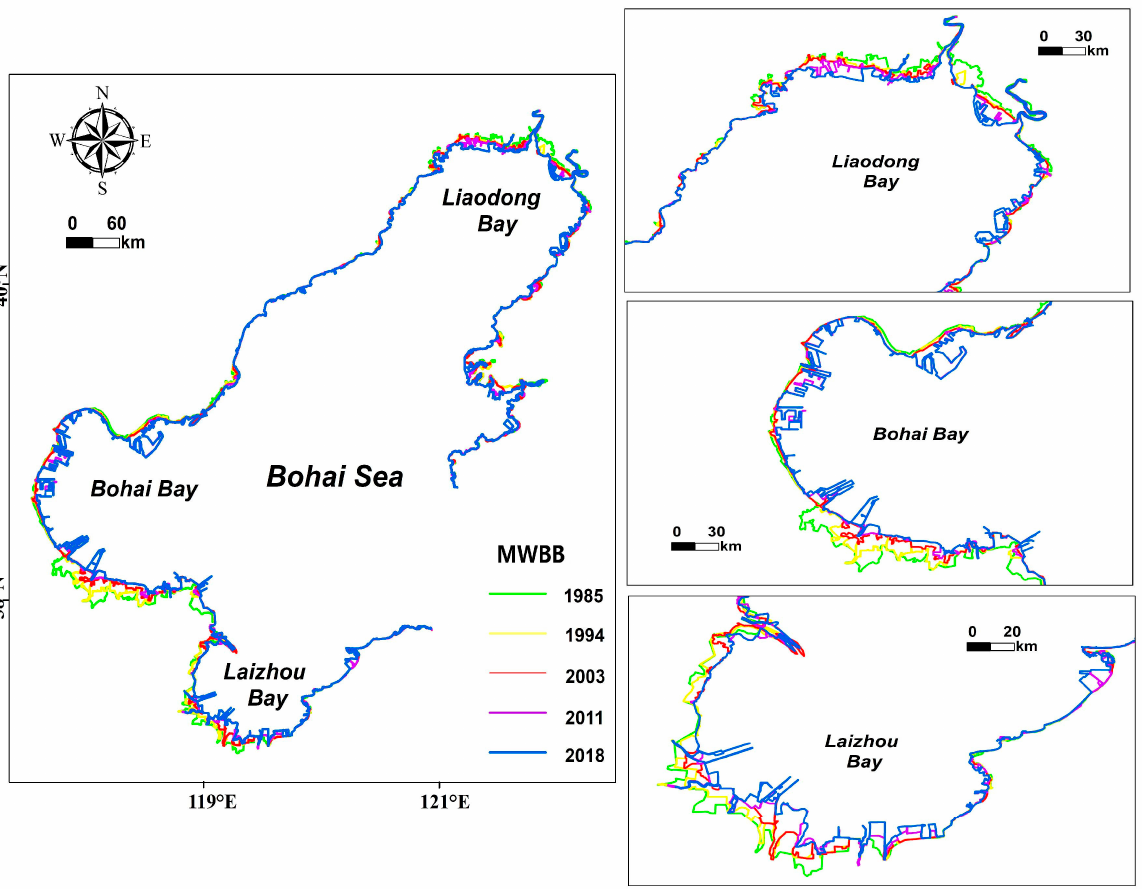
Figure 6. Spatio-temporal changes of the MWBB in the Bohai Sea.